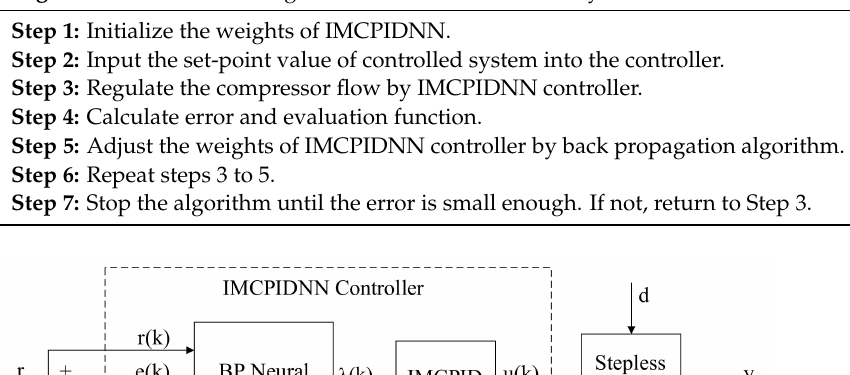
Algorithm 1 IMCPIDNN algorithm for MIMO nonlinear system.